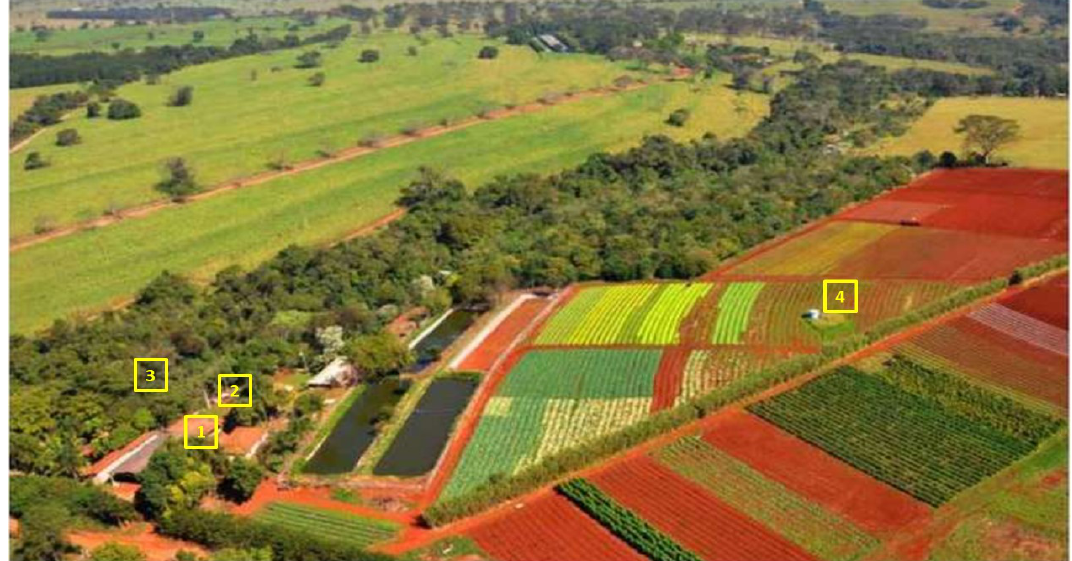
Fig. 5. São João Ranch: (1) Residence on the ranch; (2) Biodigestor septic tank system; (3) Ribeirão Feijão watershed and (4) Artesia post of the Guarani Aquifer. Adapted from Iniciativa Verde (2015), [63].